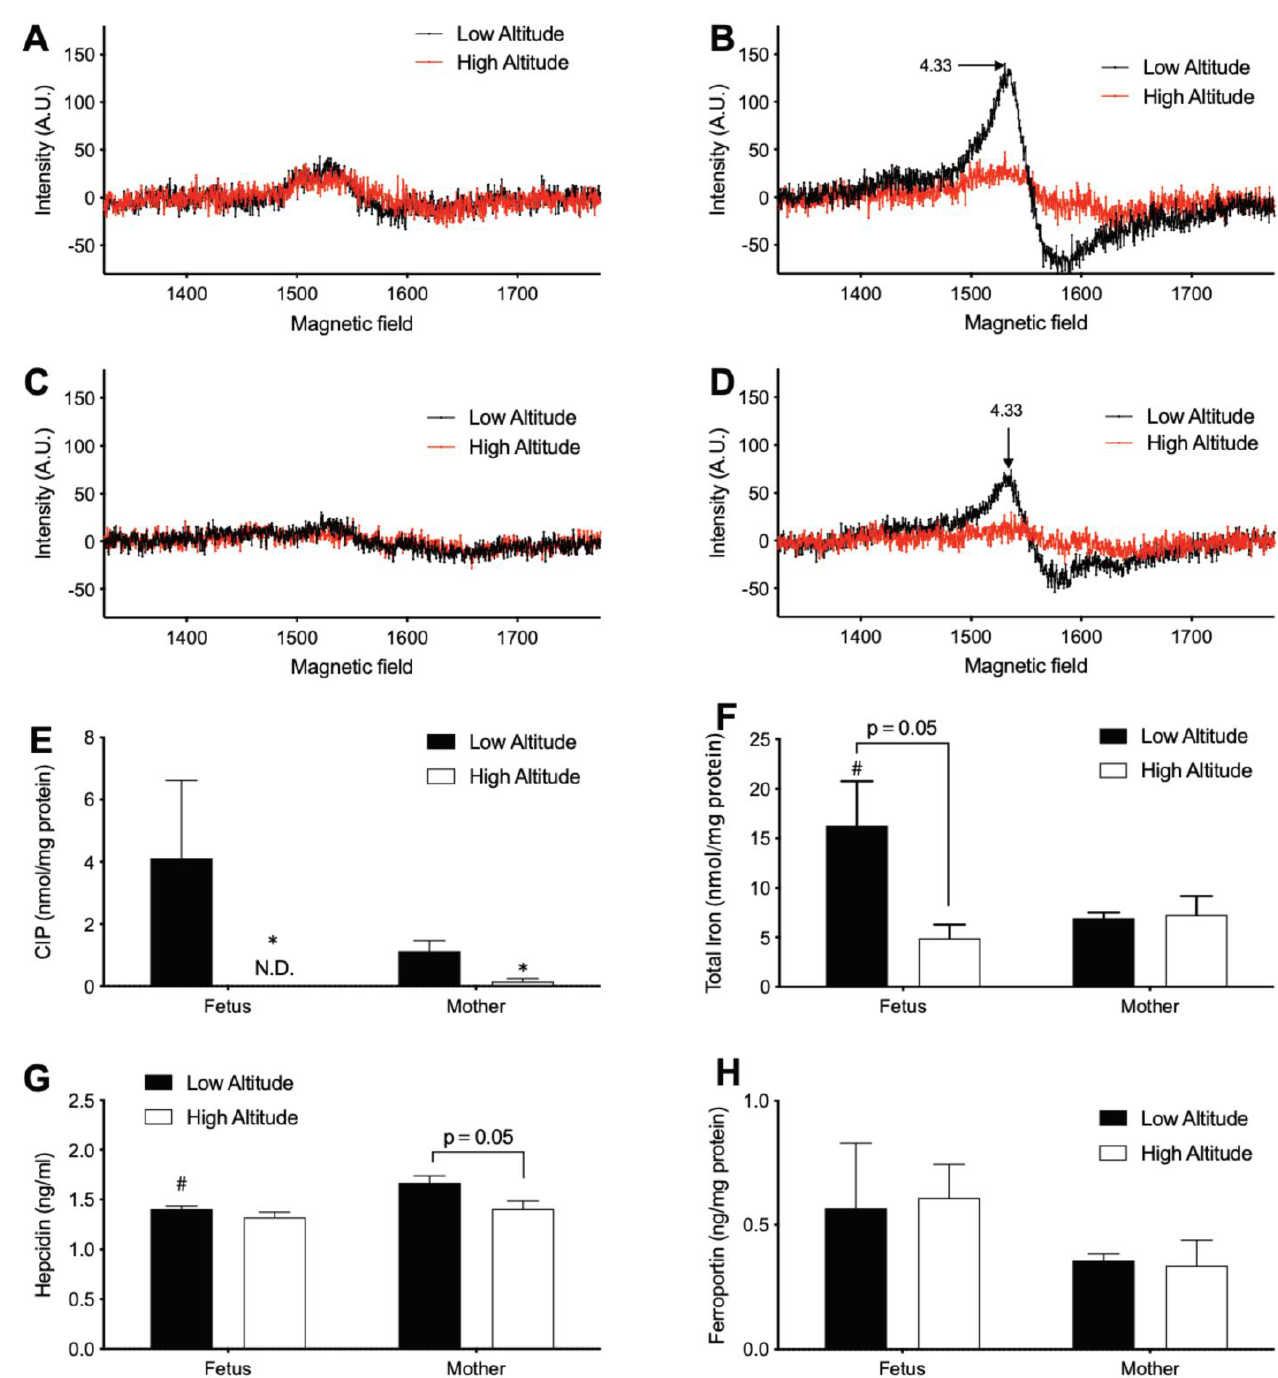
Figure 3. Iron in the aorta of high and low altitude pregnant sheep. ( A − D ) Representative EPR spectrum of aorta. ( A ) Fetal aorta. ( B ) Fetal aorta + DFO. ( C ) Mother aorta. ( D ) Mother aorta + DFO. ( E ) CIP in aorta. ( F ) Total metal iron. ( G ) Hepcidin in plasma. ( H ) Ferroportin in aorta. N.D.: not detectable. Two- way ANOVA with Sidak’s post -hoc tests. * = p < 0.05 high vs. low altitude; # = p < 0.05 fetus vs. mother. p value in ( F ) for t -test.